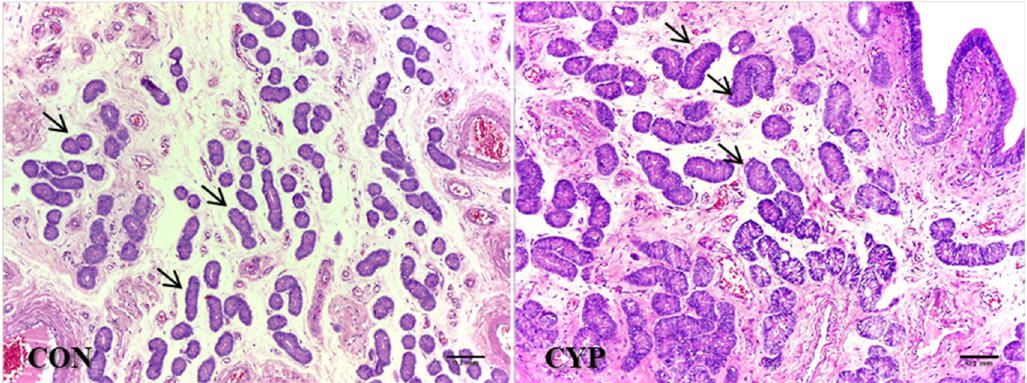
Figure 5. Histology of uterine glandular epithelium of gilts slaughtered on day 5 after insemination; gilts were inseminated at natural estrus (CON) or following induced delayed luteal regression (CYP). The mean glandular area (MGA) was higher ( p = 0.04) for the CYP group compared to the CON group (arrows).